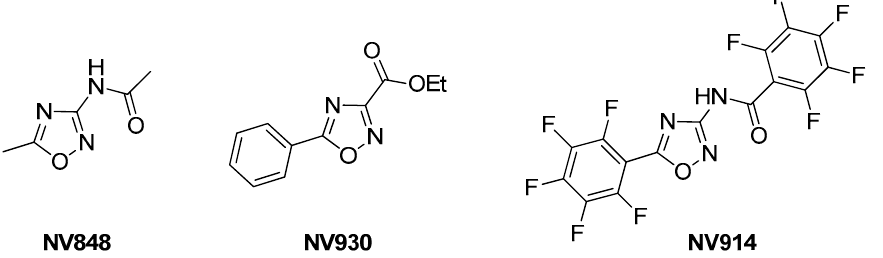
Figure 4. 1,2,4-oxadiazoles selected structures.